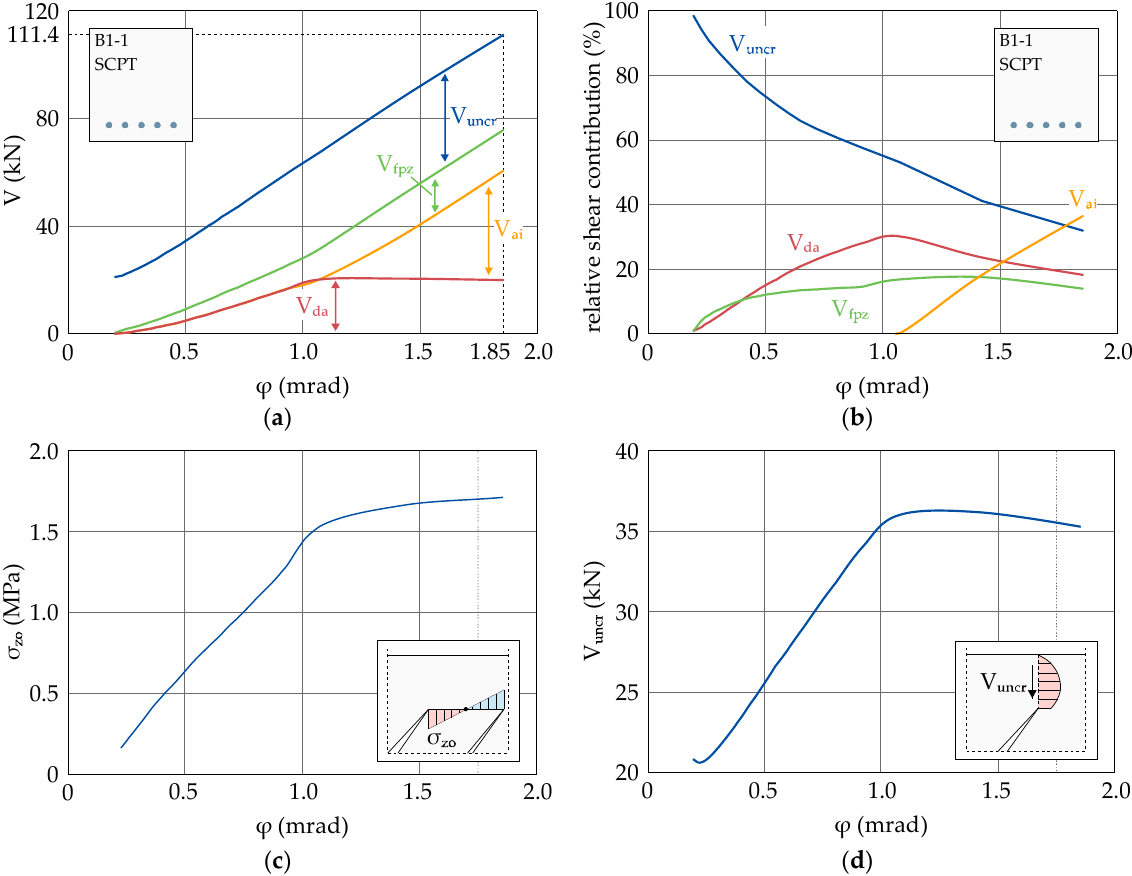
Figure 9. SCPT analysis results for the critical shear crack of subtest B1-1 with regards to the shear crack rotation φ : ( a ) shear force—rotation relationship, ( b ) relative contribution of the shear transfer actions, ( c ) development of the vertical crack tip stress σ z0 and ( d ) absolute shear force V uncr in the uncracked zone.